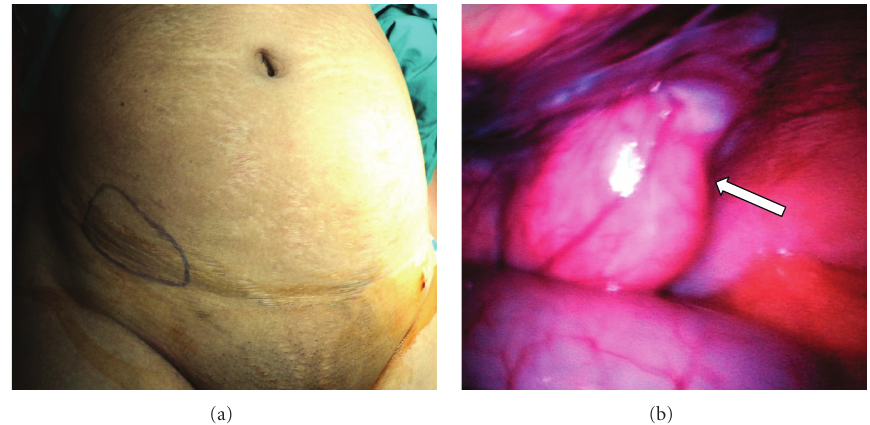
Figure 1: (a) Area of tenderness marked out on the abdominal wall prior to induction of anaesthesia. (b) Laparoscopic view of the Spigelian hernia.